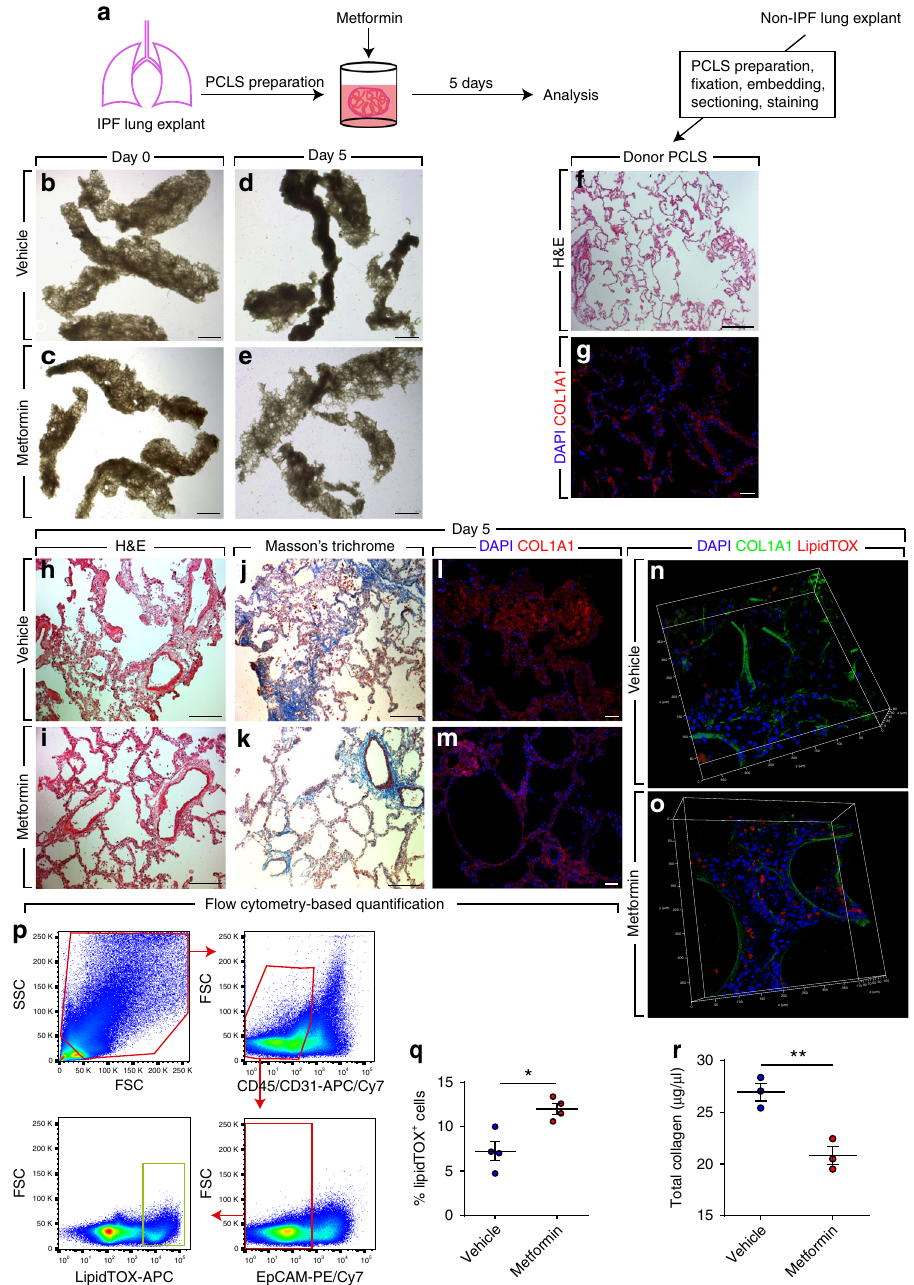
Fig. 3 Metformin improves IPF lung structure ex vivo. a Schematic representation of the experimental setup. b – e Bright- fi eld imaging of PCLS treated with metformin or vehicle for 5 days. f , g Hematoxylin and eosin staining and COL1A1 immunostaining of PCLS prepared from a non-IPF donor lung. h – m Hematoxylin and eosin staining, Masson ’ s trichrome staining and COL1A1 immunostaining of PCLS prepared from an IPF lung and treated with metformin or vehicle for 5 days. n , o 3D reconstruction of z-stacks of metformin- and vehicle-treated PCLS stained for COL1A1 (green) and lipid droplets (red). p Gating strategy for fl ow cytometry-based quanti fi cation of LipidTOX + cells that are negative for hematopoietic (CD45), endothelial (CD31), and epithelial (EpCAM) cell markers. q Quanti fi cation of fl ow cytometry measurements on metformin- and vehicle-treated cells. r Total collagen assay for metformin- and vehicle-treated cells. Scale bars: b – e 2 mm, f 500 μ m, g , l , m 50 μ m, and h – k 200 µ m. Each data point within a given group corresponds to one patient and error bars indicate s.e.m. q n = 4 per group. r n = 3 per group. Mann – Whitney test was used in ( q , r ). * P < 0.05, ** P < cytometry was carried out. The results showed similar propor- (Fig. 4g). Immuno fl uorescence staining allowed visualization of tions of tdTomato + cells in both groups (Fig. 4q), while the lineage-traced myo fi broblast-derived cells (tdTomato + ) and also con fi rmed the decrease in COL1A1 deposition upon metformin proportion of LipidTOX + mesenchymal cells increased from treatment (Fig. 4h, i). Interestingly, LipidTOX staining carried out 13.5 ± 2.5% to 18.8 ± 1.8% upon metformin treatment (Fig. 4s). on frozen sections revealed the presence of lipid droplets in More importantly, the proportion of myo fi broblast descendants tdTomato + cells at day 28 (Fig. 4j, k). In order to quantify the (tdTomato + ) that also contained lipid droplets increased impact of metformin on altering the myo fi broblast fate, fl ow from 6.8 ± 0.1% in the control group to 12.2 ± 0.5% in the